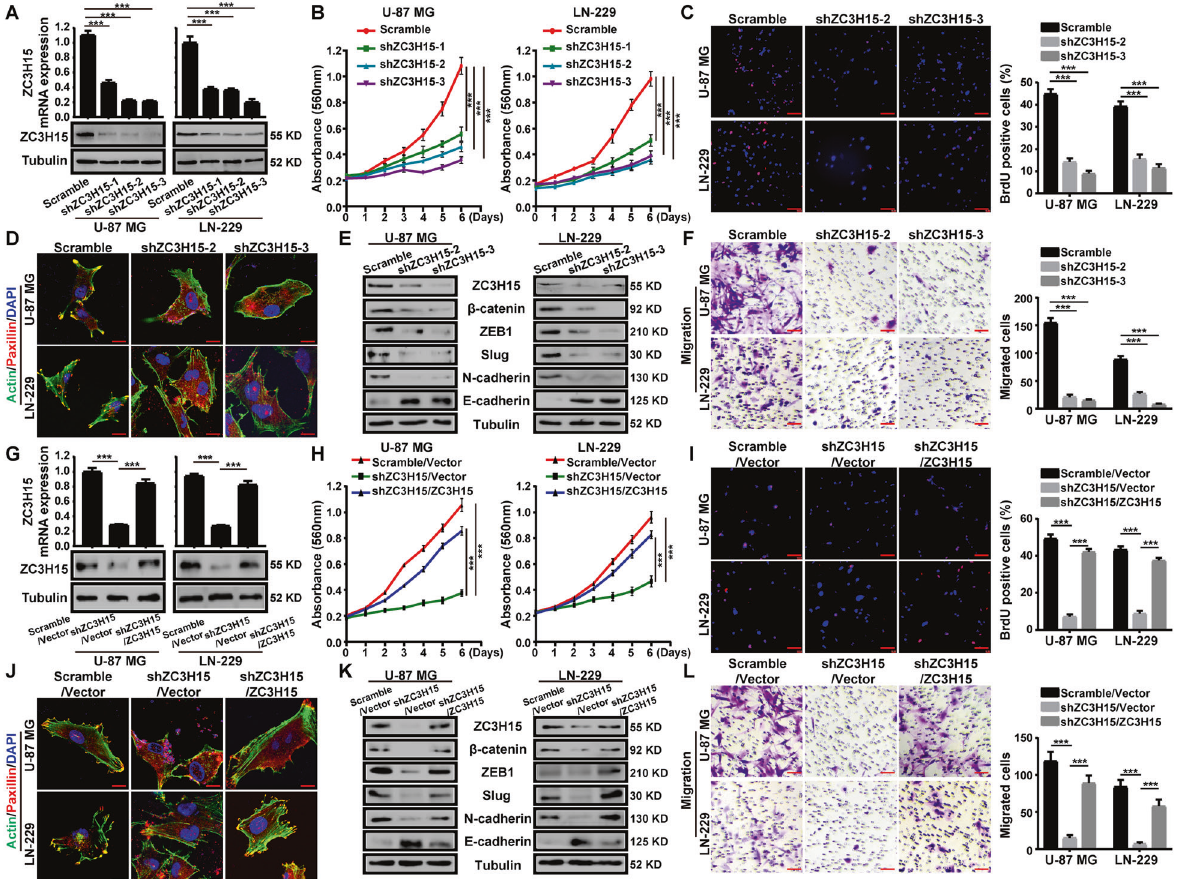
Fig. 2 ZC3H15 is essential for cell proliferation, migration and invasion of GBM cells. A Western Blot and qRT-PCR assay were performed to prove the knockdown of ZC3H15. B , C The cells viability and BrdU incorporation were detected by MTT and BrdU assay. BrdU positive cells were counted. D ZC3H15-knockdown and control cells were plated on glass slides and stained with anti-Paxillin and anti-actin antibodies. DAPI was used for nuclear staining. E The expressions of metastasis-associated proteins were evaluated through western blot analysis in ZC3H15-knockdown and control cells. Tubulin was used as a control for normalization. F The effect of ZC3H15 knockdown on cell migration was detected by transwell assay, the migrated cells were counted and analyzed. G Western blot and RT-PCR analysis were performed to detect the expression of ZC3H15 in the indicated cells. H , I The proliferation abilities of indicated cells were analyzed by MTT and BrdU assays. BrdU positive cells were counted and analyzed. J Indicated cells were plated on glass slides and stained with anti-Paxillin and anti-actin antibodies. DAPI was used for nuclear staining. K The expressions of metastasis-associated proteins were evaluated through western blot analysis in GBM cells. Tubulin was used as a control for normalization. L The migration ability of indicated cells was detected by transwell assay. All data were expressed as mean ± SD. Student ’ s t test was performed to analyzed signi fi cance. * P < 0.05, ** P < 0.01, *** P < (Fig. 1C). These results suggested that ZC3H15 played as an onco-protein. To further determine whether high expression of ZC3H15 was linked to the prognosis of tumor patients, survival data from CGGA database was analyzed. As shown in Fig. 1D, high